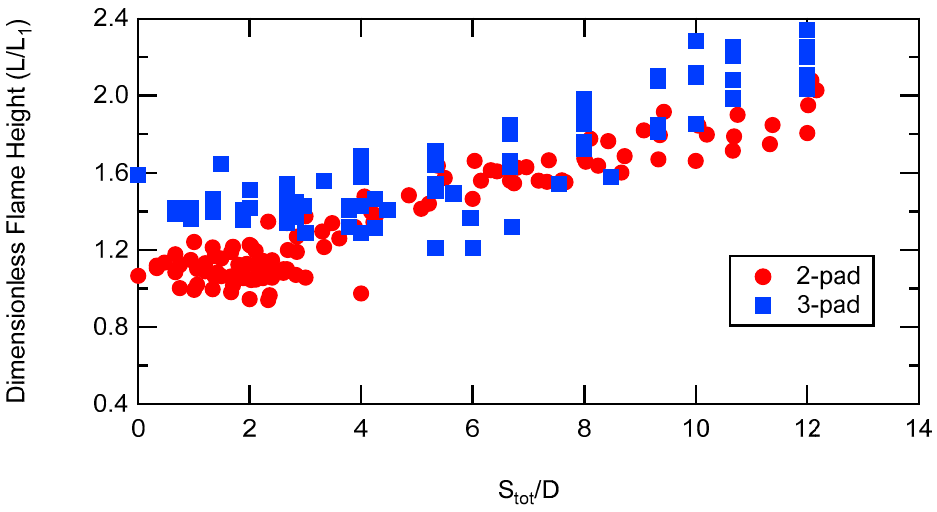
Figure 5. Comparison of two-pad and three-pad flame heights (uncorrected). Both flame height and total pad separation distance have been normalized, as described above.